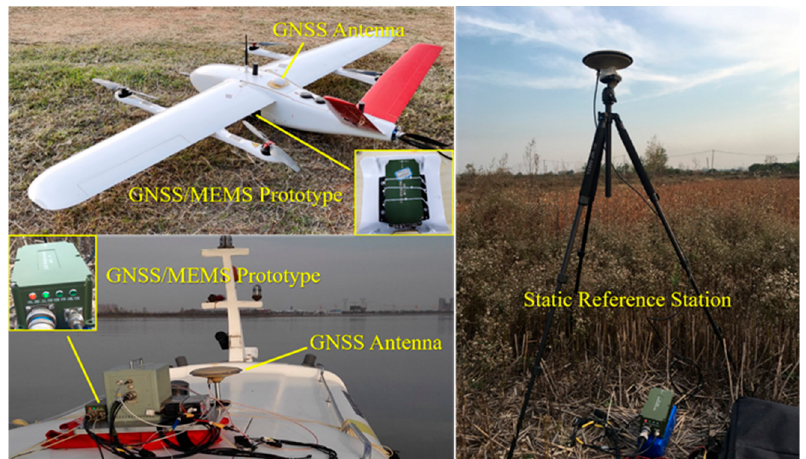
Figure 10. Experimental set up in test 2.